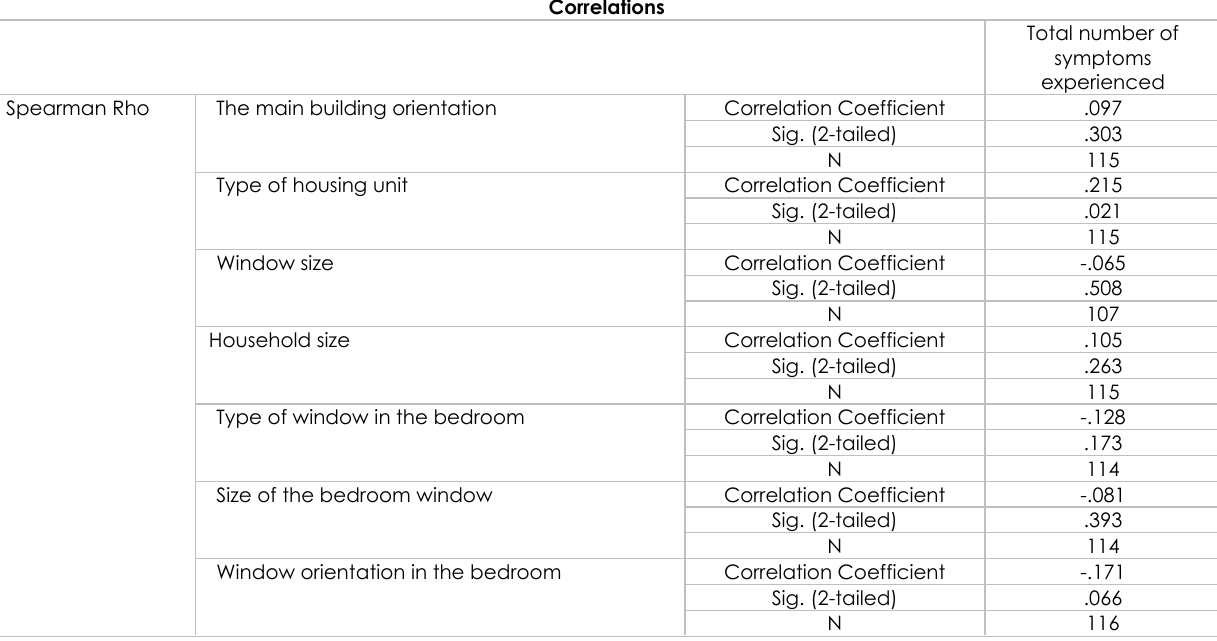
Table 3. Correlation between the number of symptoms and building parameter/air